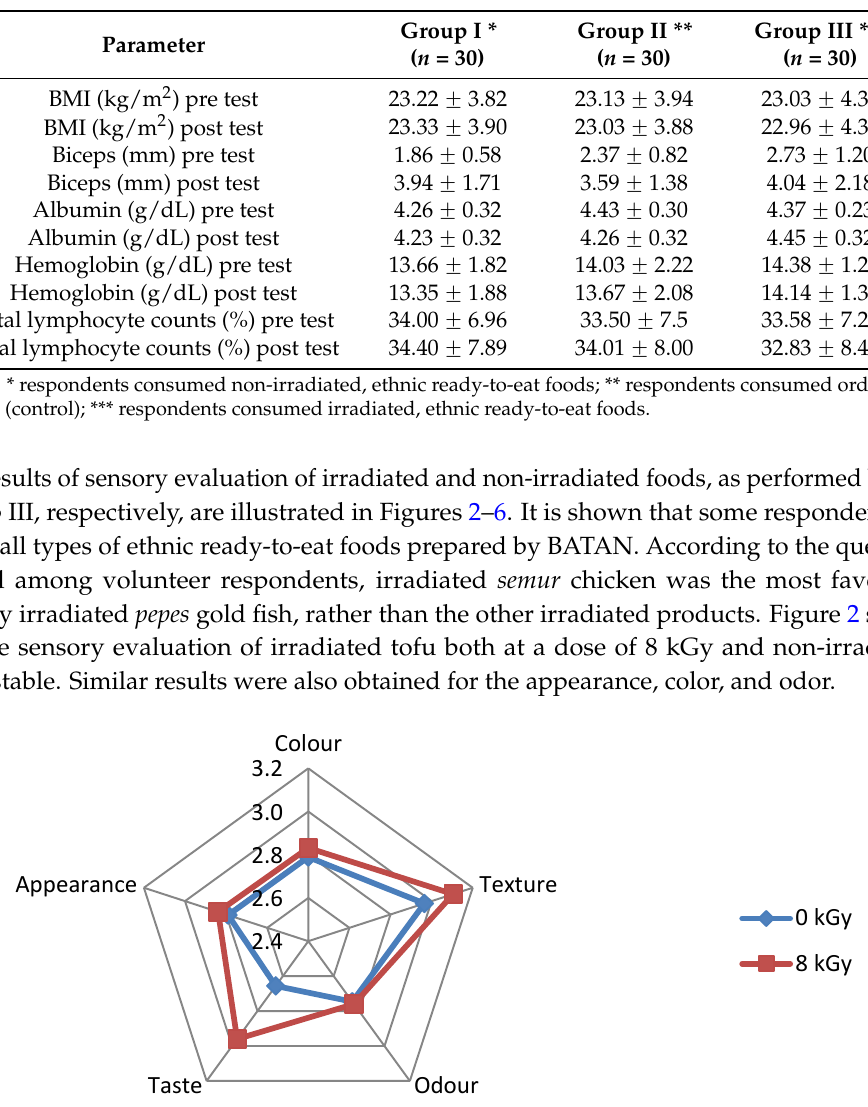
Figure 3. Sensory evaluation of non-irradiated and irradiated pepes gold fish. Figure 4. Sensory evaluation of non-irradiated and irradiated rendang beef.